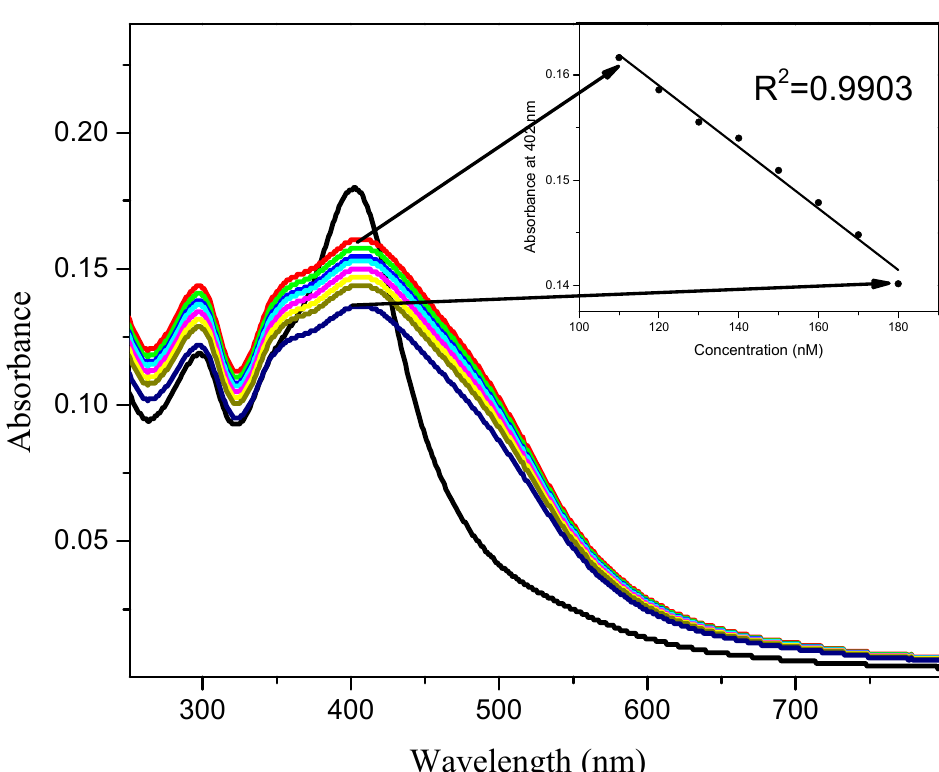
Figure 6. UV-visible spectra of Ferene-S-AgNPs in the presence of different concentrations of Fe 2+ .